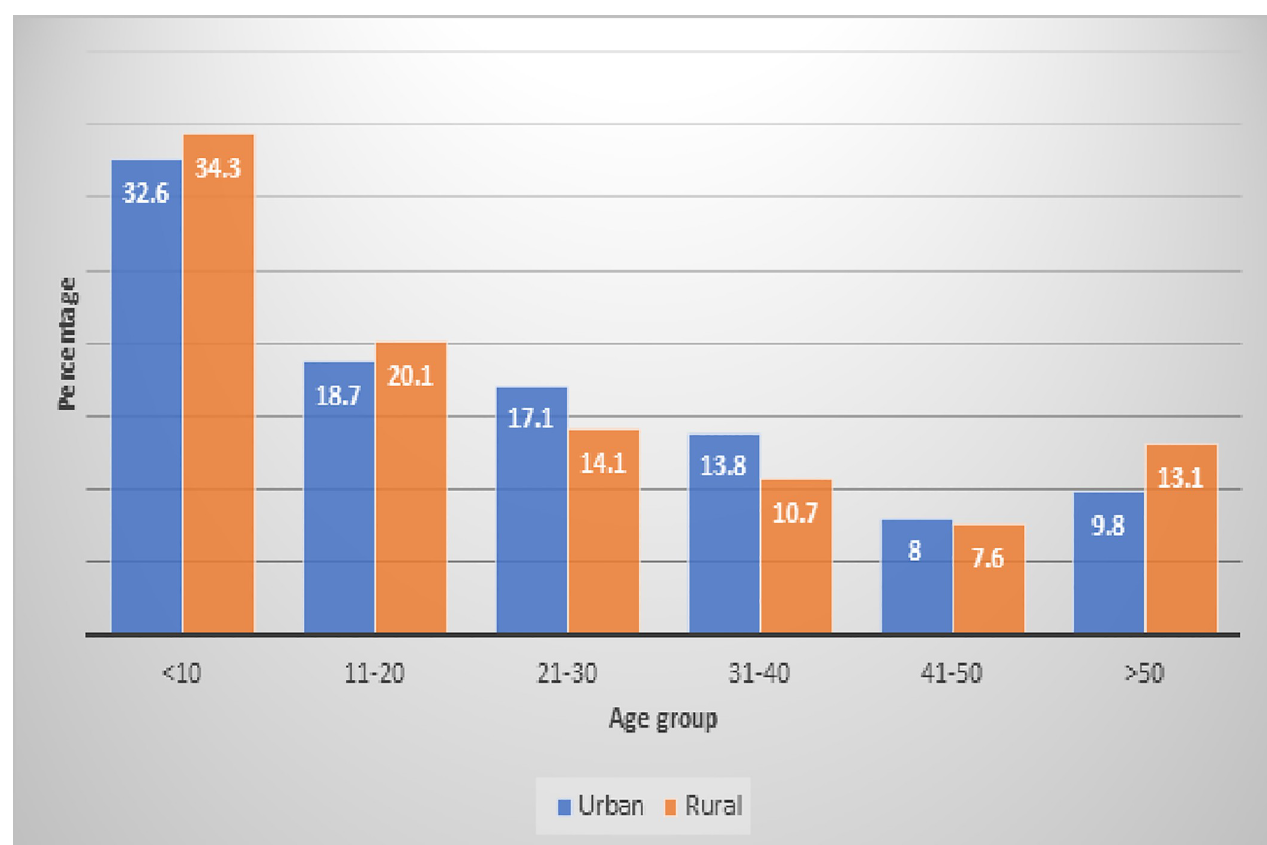
Fig 4. Household population by age category, AKAIS 2017. A total of 8,306 people aged 15 years and older were tested for HIV in Akwa-Ibom state (Table 3). Of the 8,963 adults aged 15 years and older interviewed, point prevalence of HIV was 4.8% (95% CI 4.2–5.3). HIV prevalence was about 5.1% in rural areas, compared to about 3.9% in urban areas in this age group (p = 0.04). HIV prevalence was significantly higher in females (5.6%) than males (3.7%) aged 15 years